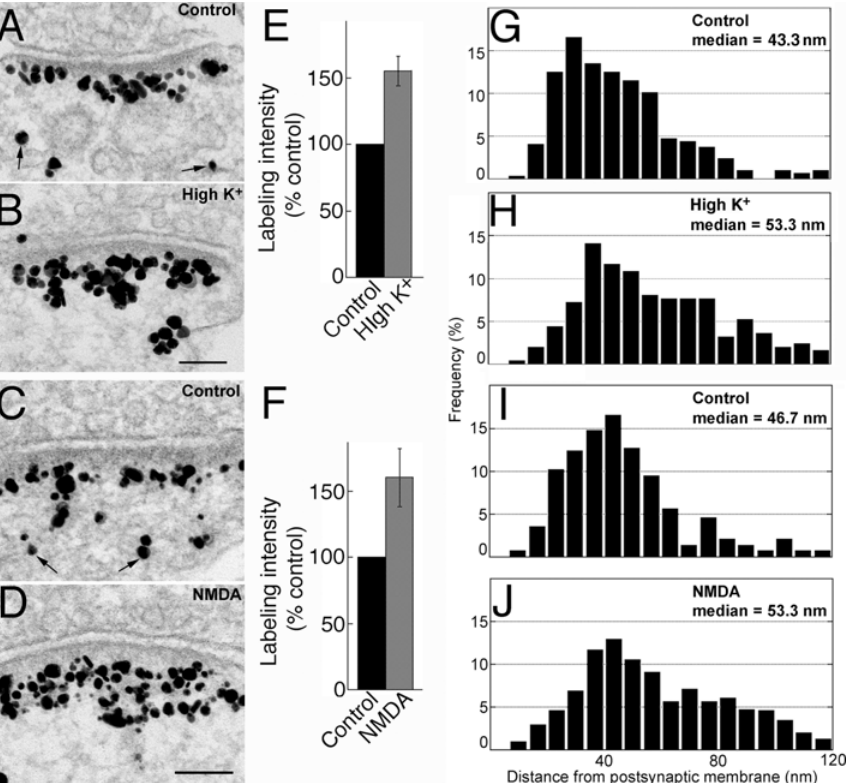
Fig 4. (A-D) Electron micrographs of asymmetric synapses from dissociated hippocampal cultures labeled for Shank3 using ab2. Scale bars = 0.1 μ m (A and B share the same scale bar, C and D share the same scale bar). Labeling intensity increased upon 2 min treatment with either high K + (B vs. A) or NMDA (D vs. C). (E, F) Bar graphs represent combined data (mean ± SEM) from S1 and S2 Tables. (G-J) Histograms from a typical experiment depicting frequency distribution of gold particles as a function of distance from the postsynaptic membrane. Median distance of label from postsynaptic membrane increased after high K + (H vs. G) or NMDA treatment (J vs. I), indicating preferential recruitment of Shank3 molecules to the distal layer of the